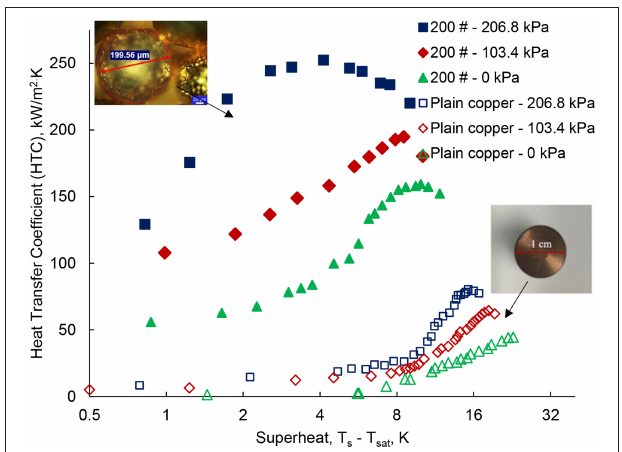
FIGURE 7 | The performance of high-pressure pool-boiling for three different gauge pressures; 0, 103.4, and 206.8 kPa. Heat Transfer Coefficient (HTC) in kW/m 2 K vs. Heat Flux (q ′′ ) in W/cm 2